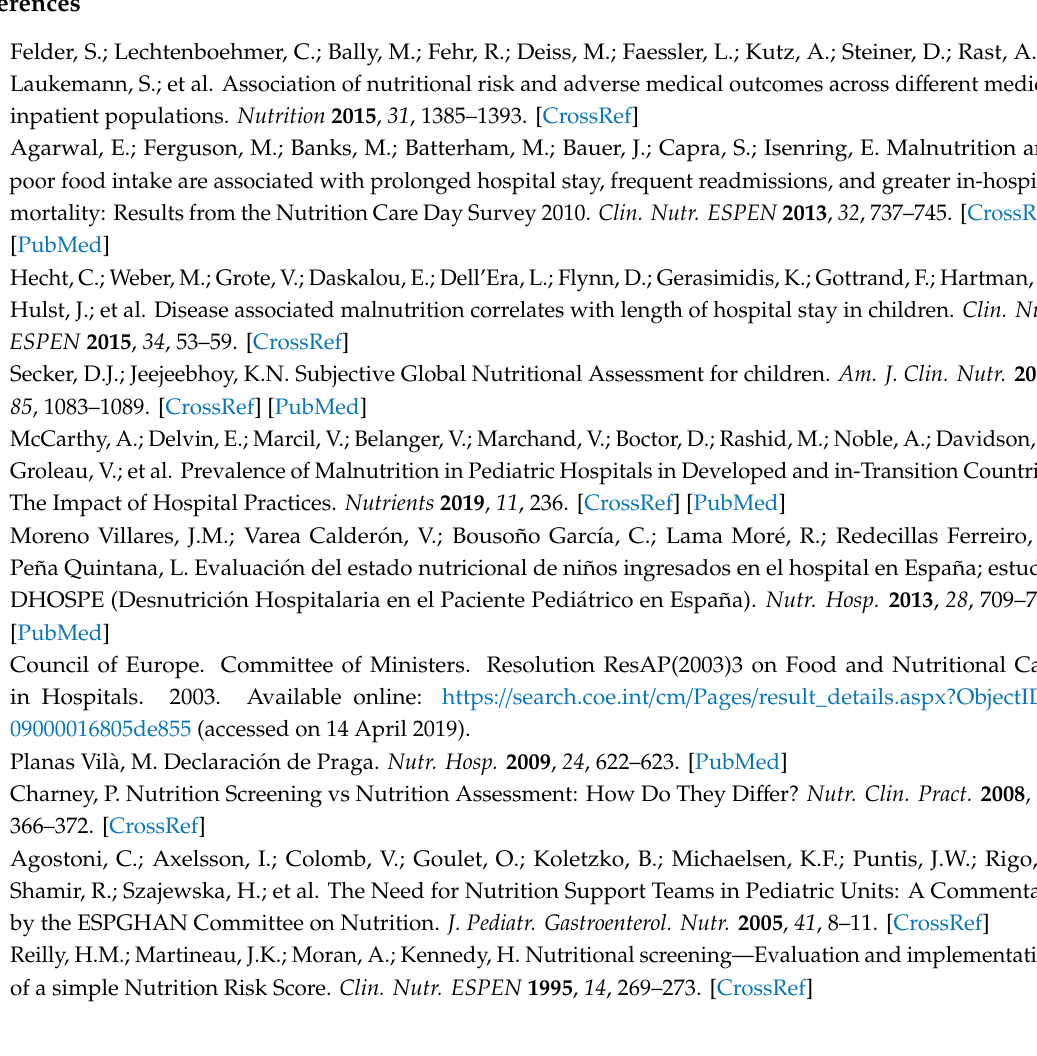
Table S1: First four steps of Screening Tool for the Assessment of Malnutrition in Paediatrics (STAMP). Original tool also includes a fifth step about developing a care plan based on the child’s overall risk of malnutrition (http: // www.stampscreeningtool.org), Table S2: Screening Tool for Risk On Nutritional status and Growth (STRONGkids)